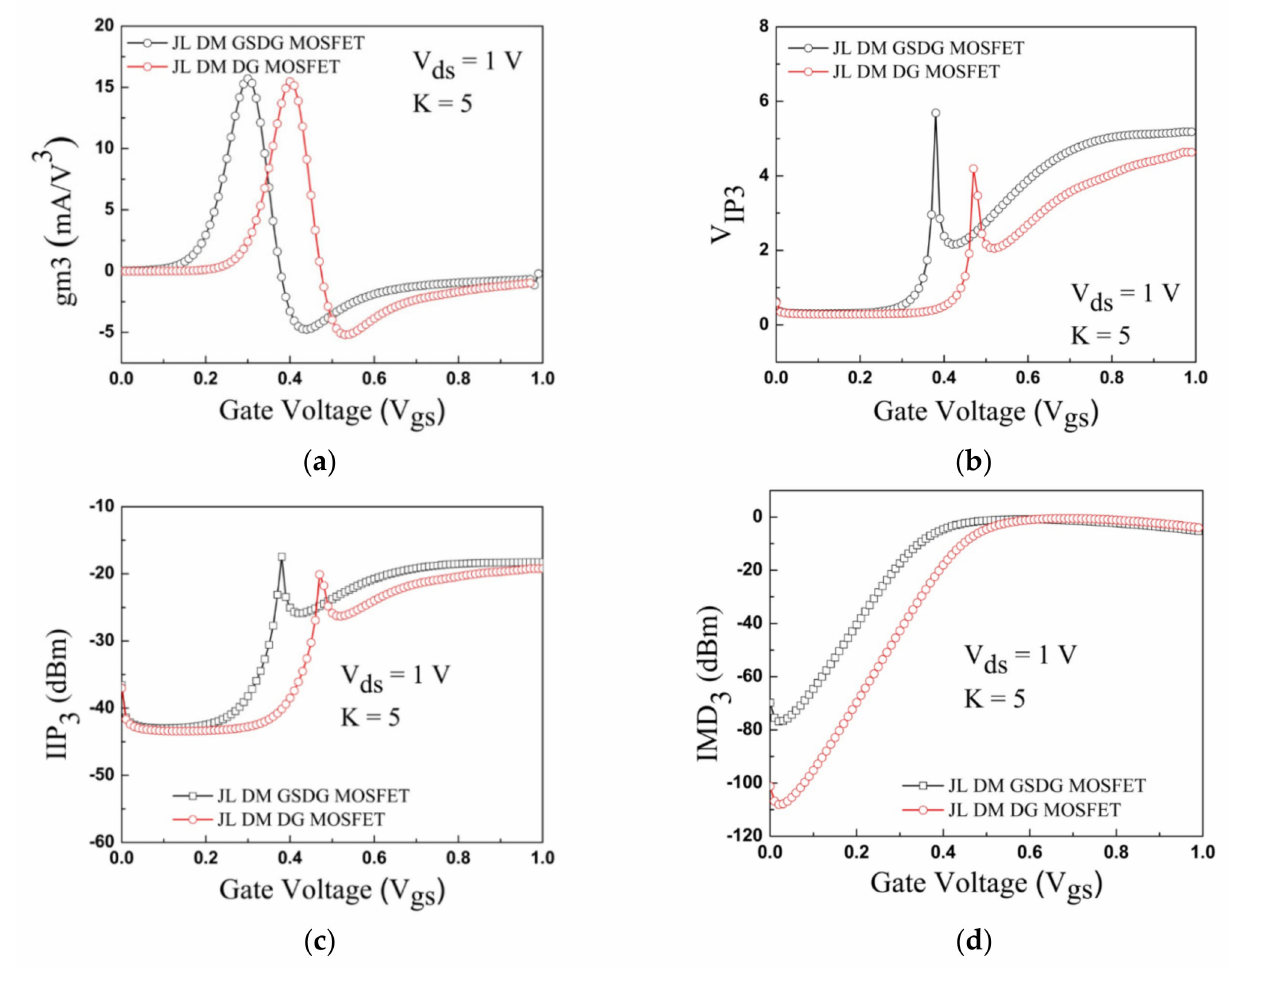
Figure 16. Variation in ( a ) gm3 , ( b ) V IP3 , ( c ) IIP 3 , and ( d ) IMD 3 with gate voltage for JL-DM-DG- MOSFET and JL-DM-GSDG-MOSFET biosensor at K =